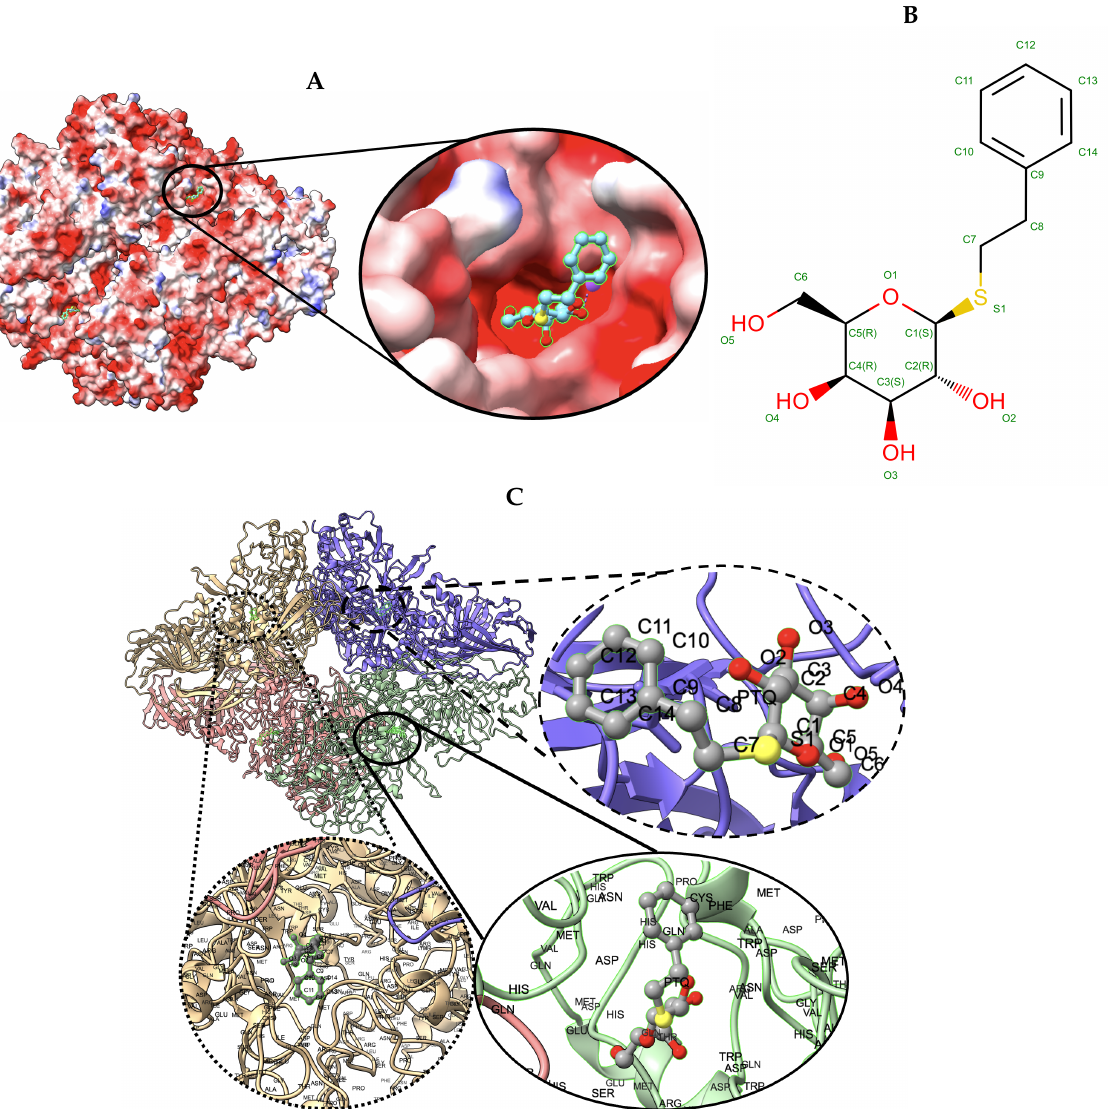
Figure 6. Target 201. ( A ) T0201EM004_1 (ours) docked by Target 201 (EMD-7770) and visualized with electrostatic potential surface generated in UCSF Chimera. ( B ) Ligand PTQ, image extracted from Protein Data Bank (PDB). ( C ) Protein–ligand interactions in T0201EM004_1 (ours) model. Chains are colored differently (chain A: blue, chain B: pink, chain C: green and chain D: golden). The ligand is labeled with its atom names as well as the ligand name (PTQ). For chain D: golden and chain C: green, we have labeled the chain residue names for understanding protein–ligand interaction